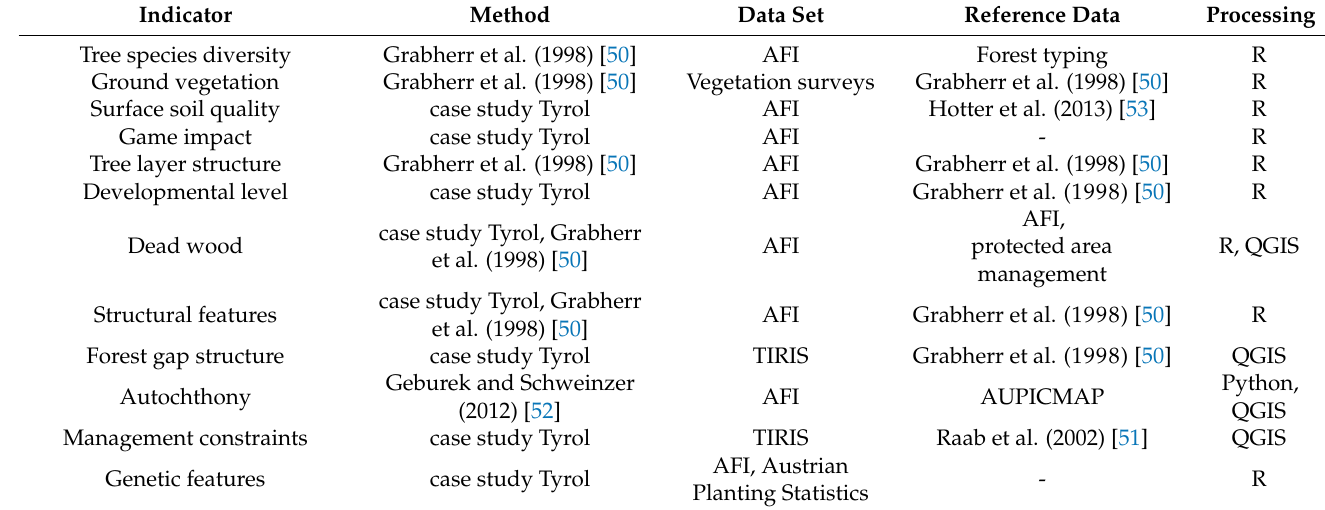
Table 1. Data provision and processing. Twelve biodiversity indicators are established based on data sets provided by the Austrian Research Centre for Forests, the Tyrolean Regional Government, and national park